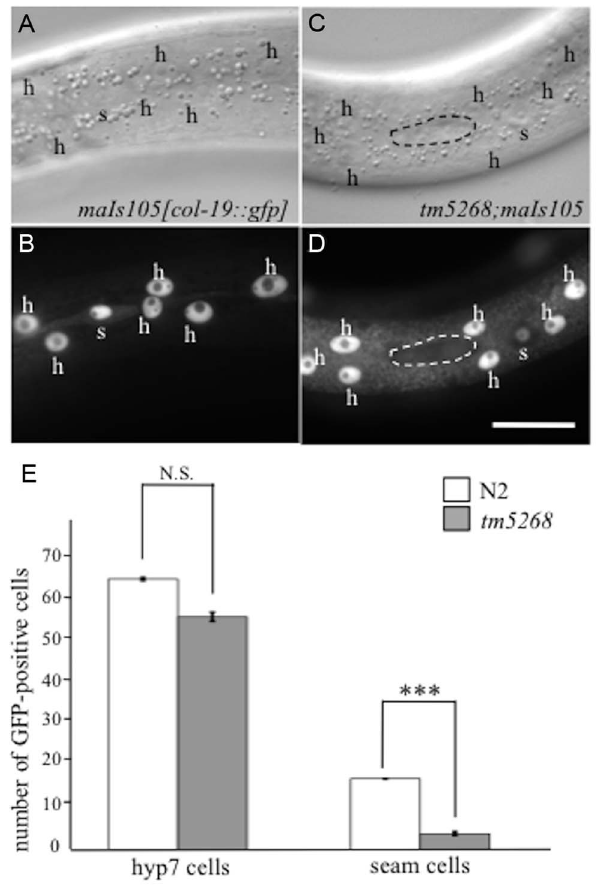
Fig. 2. BCL-7 is involved in asymmetric cell differentiation of the epidermis in Caenorhabditis elegans . A–D : Examples of col- 19p::gfp localization in wild-type and tm5268 adult hermaphrodites. Nomarski ( A, C ) and GFP images ( B, D ) of wild-type (A, B) and tm5268 (C, D) adult hermaphrodites carrying col-19::gfp reporters. A wild-type hermaphrodite expressing col-19p::gfp in both hyp7 cells (‘h’) and seam cells (‘s’), ( B ) and a tm5268 hermaphrodite expressing col-19p::gfp in hyp7 cells but not in seam cells (surrounded with a dotted oval) ( D ). E : Bar chart of the cell numbers expressing col-19::gfp in wild-type and tm5268 adult hermaphrodites (n=15–20) for hyp7 and seam cells. Error bars indicate SEM. Asterisks indicate statistical significance compared with each other. ***p , 0.001. N.S.: no significance. Scale bar =25 m